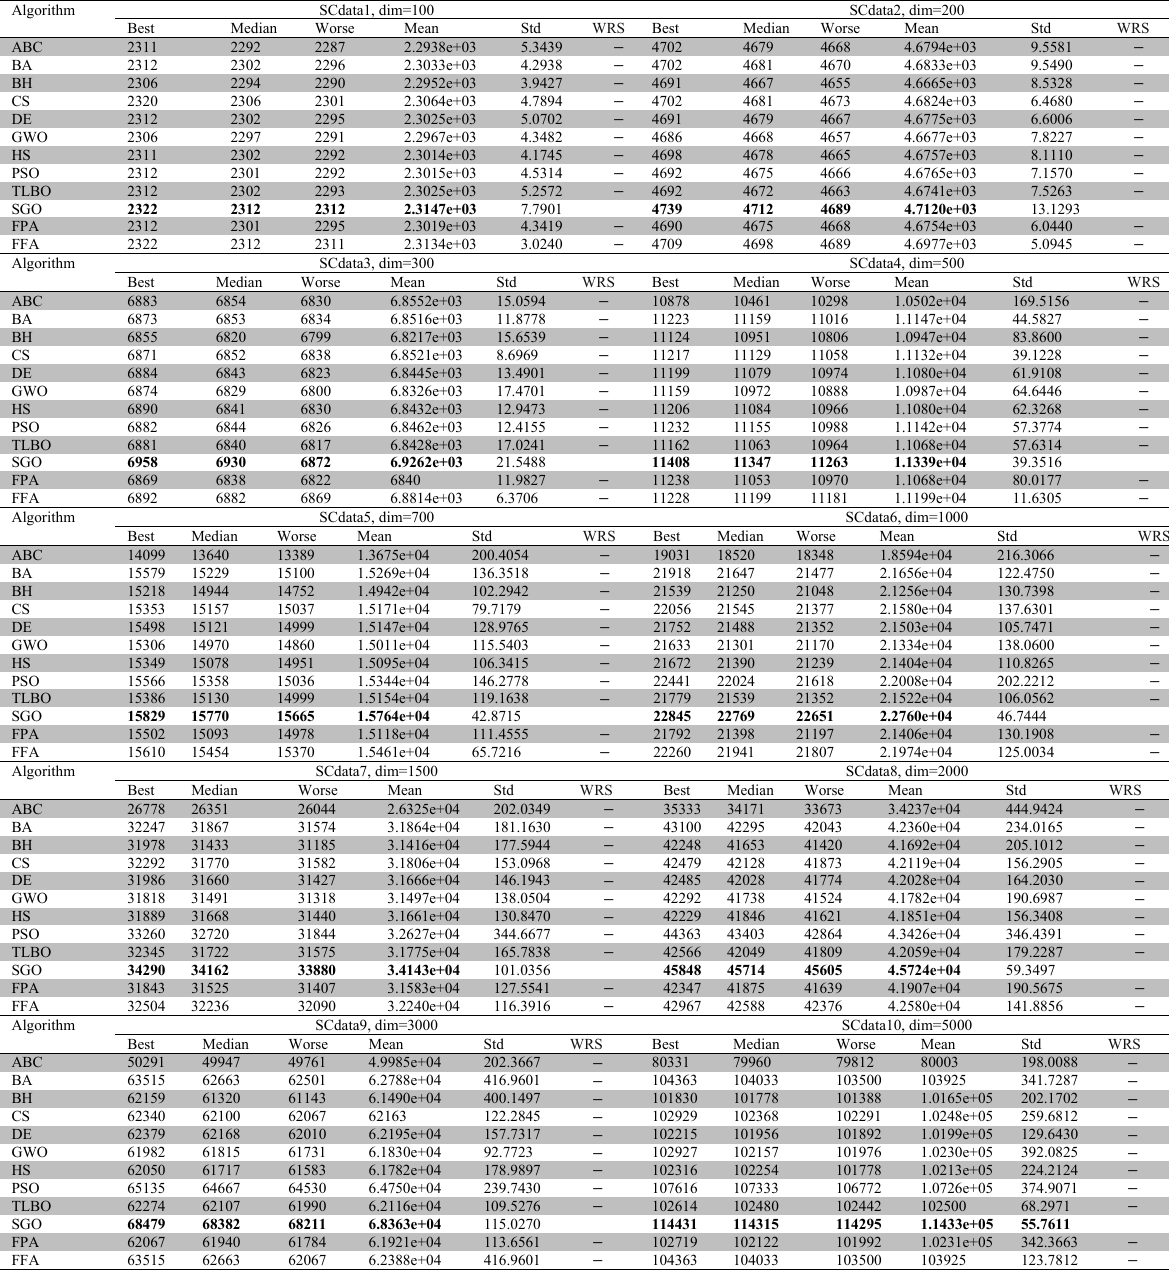
Results of SC data high dimensional 01knapsack problem , 30 different runs, 200 generation